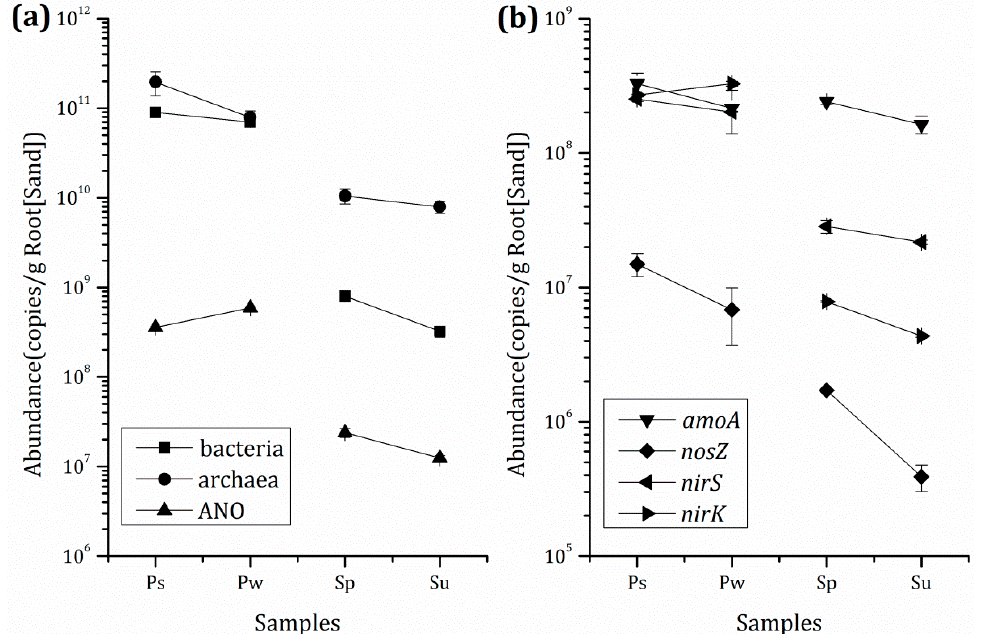
Figure 2. Absolute abundances of microbial communities and functional genes: ( a ) bacterial 16S rRNA, archaeal 16S rRNA, and 16S rRNA related to anammox bacteria; ( b ) amoA , nosZ , nirS , and nirK ( n = 3). Ps: sample from rhizoplane in Tcw; Pw: sample from rhizoplane in Tcp; Sp: sample from sand in Tcw; Su: sample from sand in Tcs. The microbial samples from the plants rhizoplane and the substrate were obtained in the end of the 6th batch.